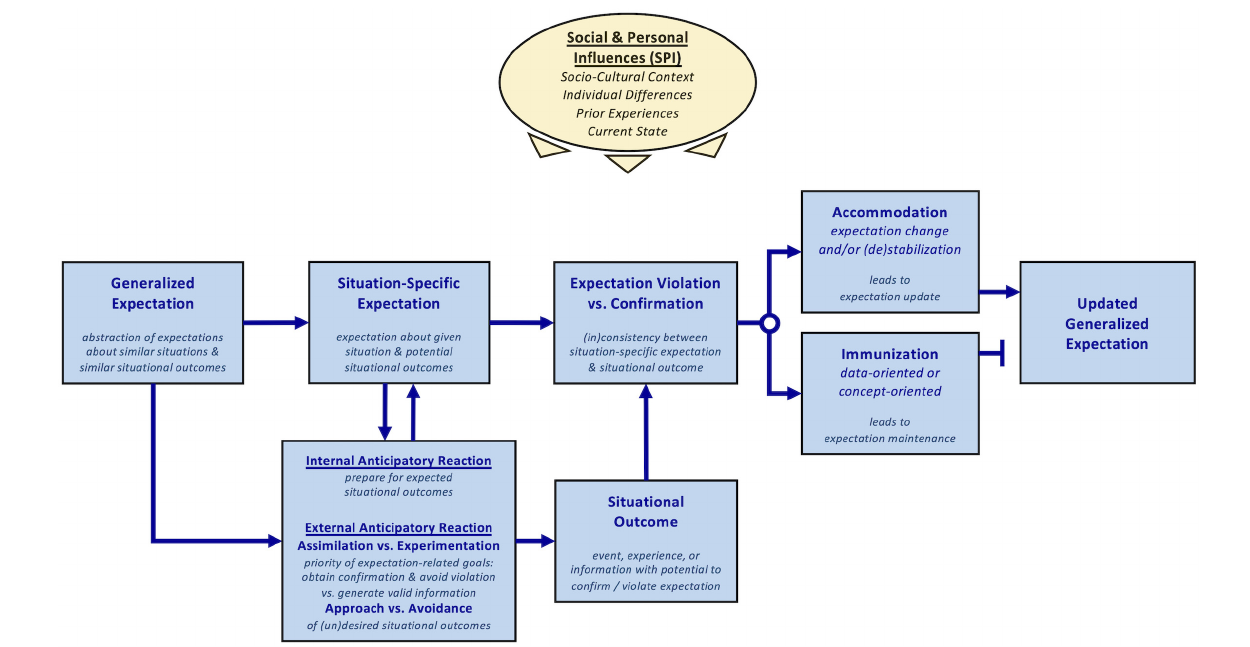
FIGURE 2 | Conceptual level (Level 1) of the ViolEx 2.0 model. Generalized expectations inform situation-specific expectations. Anticipatory reactions are triggered reactively by situation-specific expectations or proactively by generalized expectations and can influence the actual or experienced situational outcome (i.e., expectation-relevant events, experiences, or information). ViolEx 2.0 distinguishes between (a) internal anticipatory reactions (typically in the attentional, cognitive-affective, or physiological domain) that aim at optimizing responses to expected situational outcomes and (b) external anticipatory reactions, that is, overt behaviors that aim at changing the probabilities of potential situational outcomes. Assimilation describes behavior to obtain or generate expectation confirmation and avoid expectation violation. Experimentation describes behavior to obtain or generate valid expectation-relevant information regardless of whether this information confirms or violates prior expectations. Approach and avoidance describe behaviors that aim to increase the probability of desirable outcomes and decrease the probability of undesirable outcomes, respectively. When external anticipatory reactions change the antecedents in the situation, the situation-specific expectation is adjusted accordingly. The comparison between expectations and situational outcomes can result in different magnitudes of expectation violation, that is, the degree of inconsistency between the situation-specific expectation and the situational outcome (no inconsistency being a case of expectation confirmation). Individuals can respond to expectation violations (or confirmations) with accommodation, that is, updating their generalized expectation by integrating the evidence, or with immunization, that is, by minimizing the situational outcome’s impact on the generalized expectation. Different social and personal influences are associated with expectation characteristics and modulate expectation-relevant